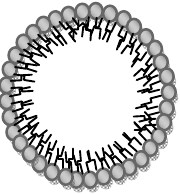
Figure 1. Proposed structure of solid lipid nanoparticles (SLNs), the interior structure varies from amorphous to